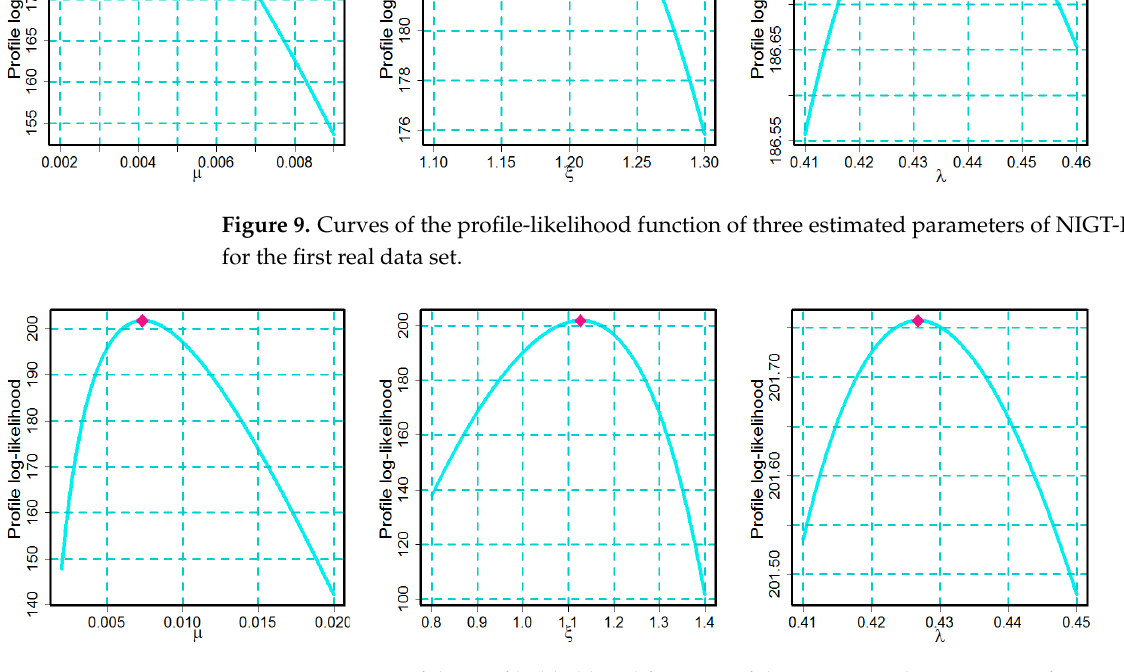
Figure 10. Curves of the profile-likelihood function of three estimated parameters of NIGT-II model for the second real data set